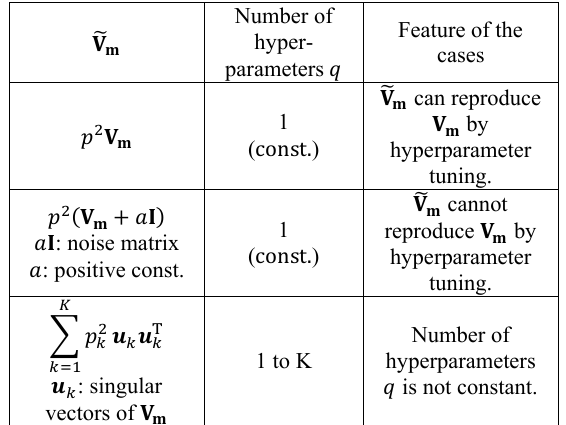
Table 3. Assumptions of 𝐕(cid:3561)